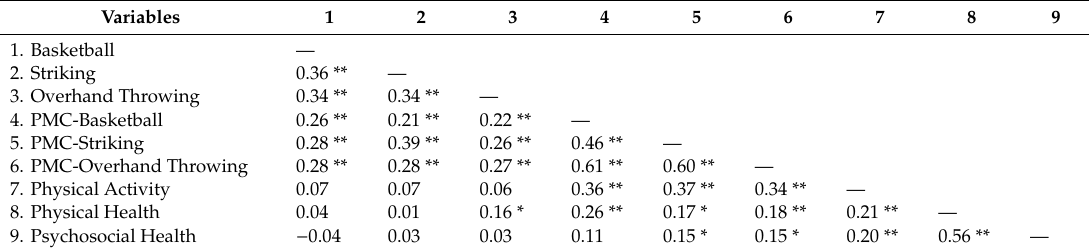
Table 3. Correlations among the study variables ( N = 215).